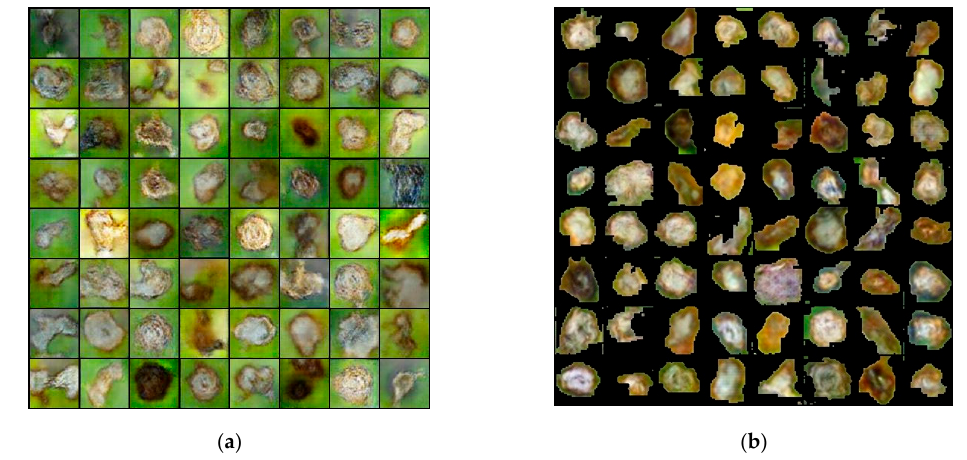
Figure 5. Images of citrus canker lesions generated using our method: ( a ) generated citrus canker and ( b ) citrus canker after binarization.